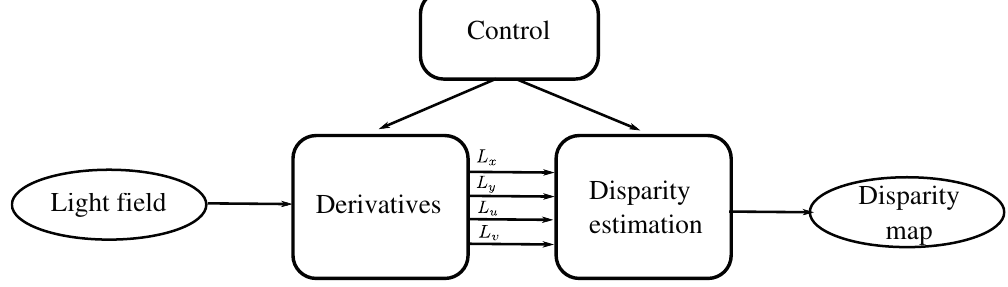
Figure 3. General system